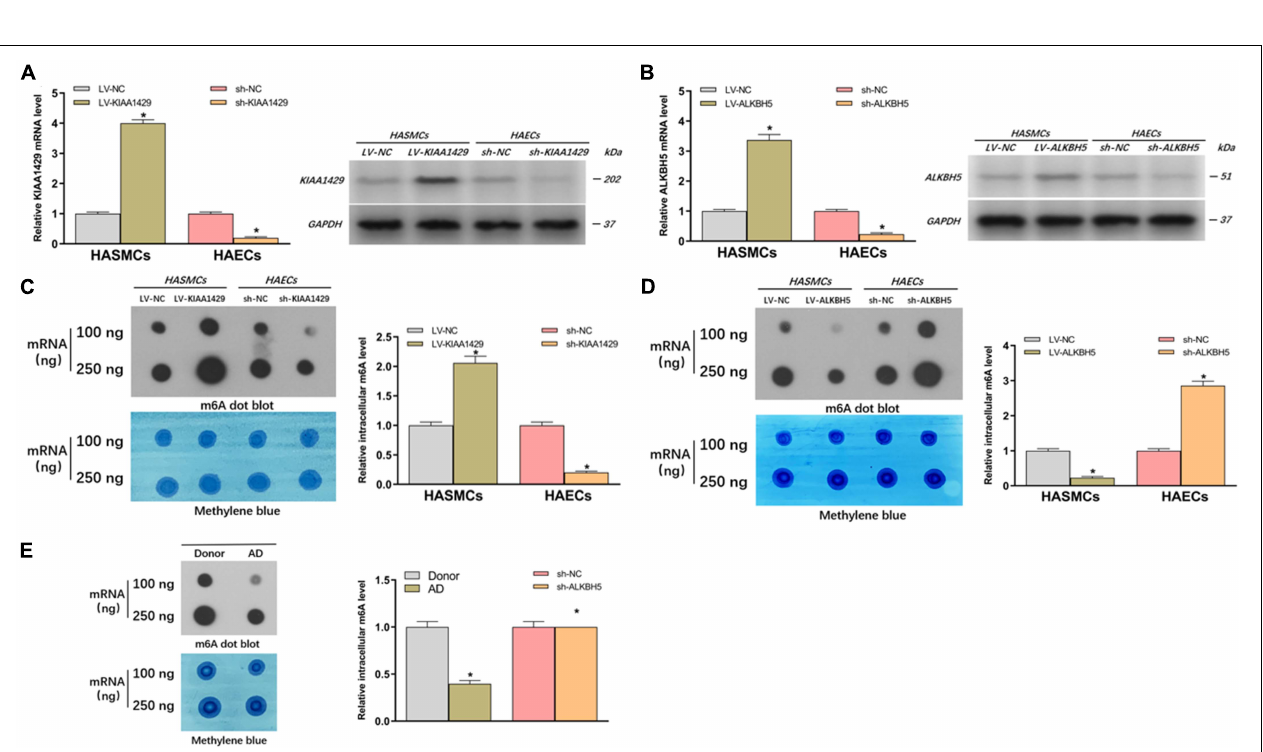
FIGURE 2 | KIAA1429 enhances while ALKBH5 reduces m6A levels in HASMCs and HAECs. (A,B) The interference effects on KIAA1429 and ALKBH5 expression in HASMCs and HAECs were detected by qRT-PCR and Western blot. (C) Dot blot assays showed that overexpression or silencing of KIAA1429 significantly increased and decreased the level of m6A, respectively. (D) ALKBH5 could negatively regulate intracellular m6A levels. (E) The m6A level was lower in the aortic tissues from AD patients compared with donors. Data are presented as the mean ± SEM ( N ≥ 3 per group); * p < 0.05.